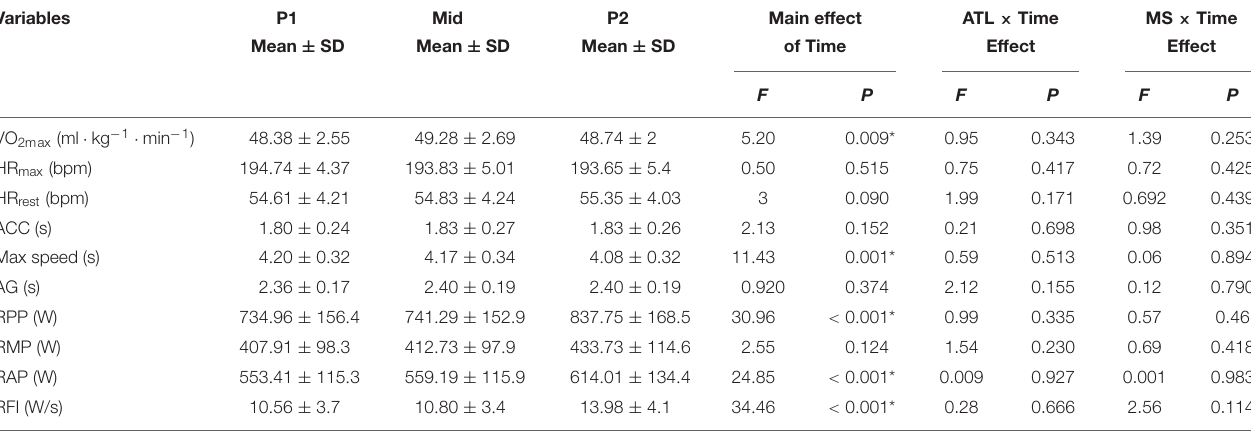
TABLE 3 | Accumulated training load and maturation status data for fitness tests and relationship with different time points. Variables P1 Mid